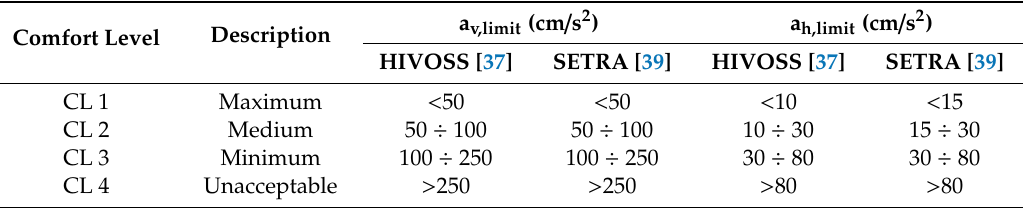
Table 7. Vertical (a v,limit ) and transverse (a h,limit ) acceleration limits for di ff erent comfort levels. a v,limit (cm / s 2 ) a h,limit (cm / s 2 ) Comfort Level Description HIVOSS [37] SETRA